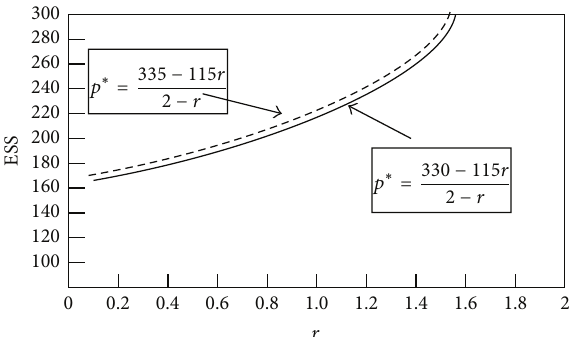
Figure 2: The relationship between ESS ( 𝑝 ∗ ) of producer’s bidding and market demand ( 𝑟 ).